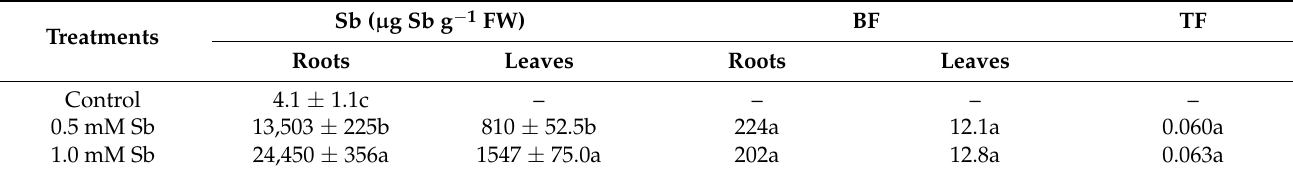
Table 2. Sb content in roots and leaves, bioaccumulation factor (BF), and translocation factor (TF) in D. viscosa plants. The data are from 10 independent experiments, each carried out in triplicate (different letters indicate significant differences at p < 0.05, Mann–Whitney